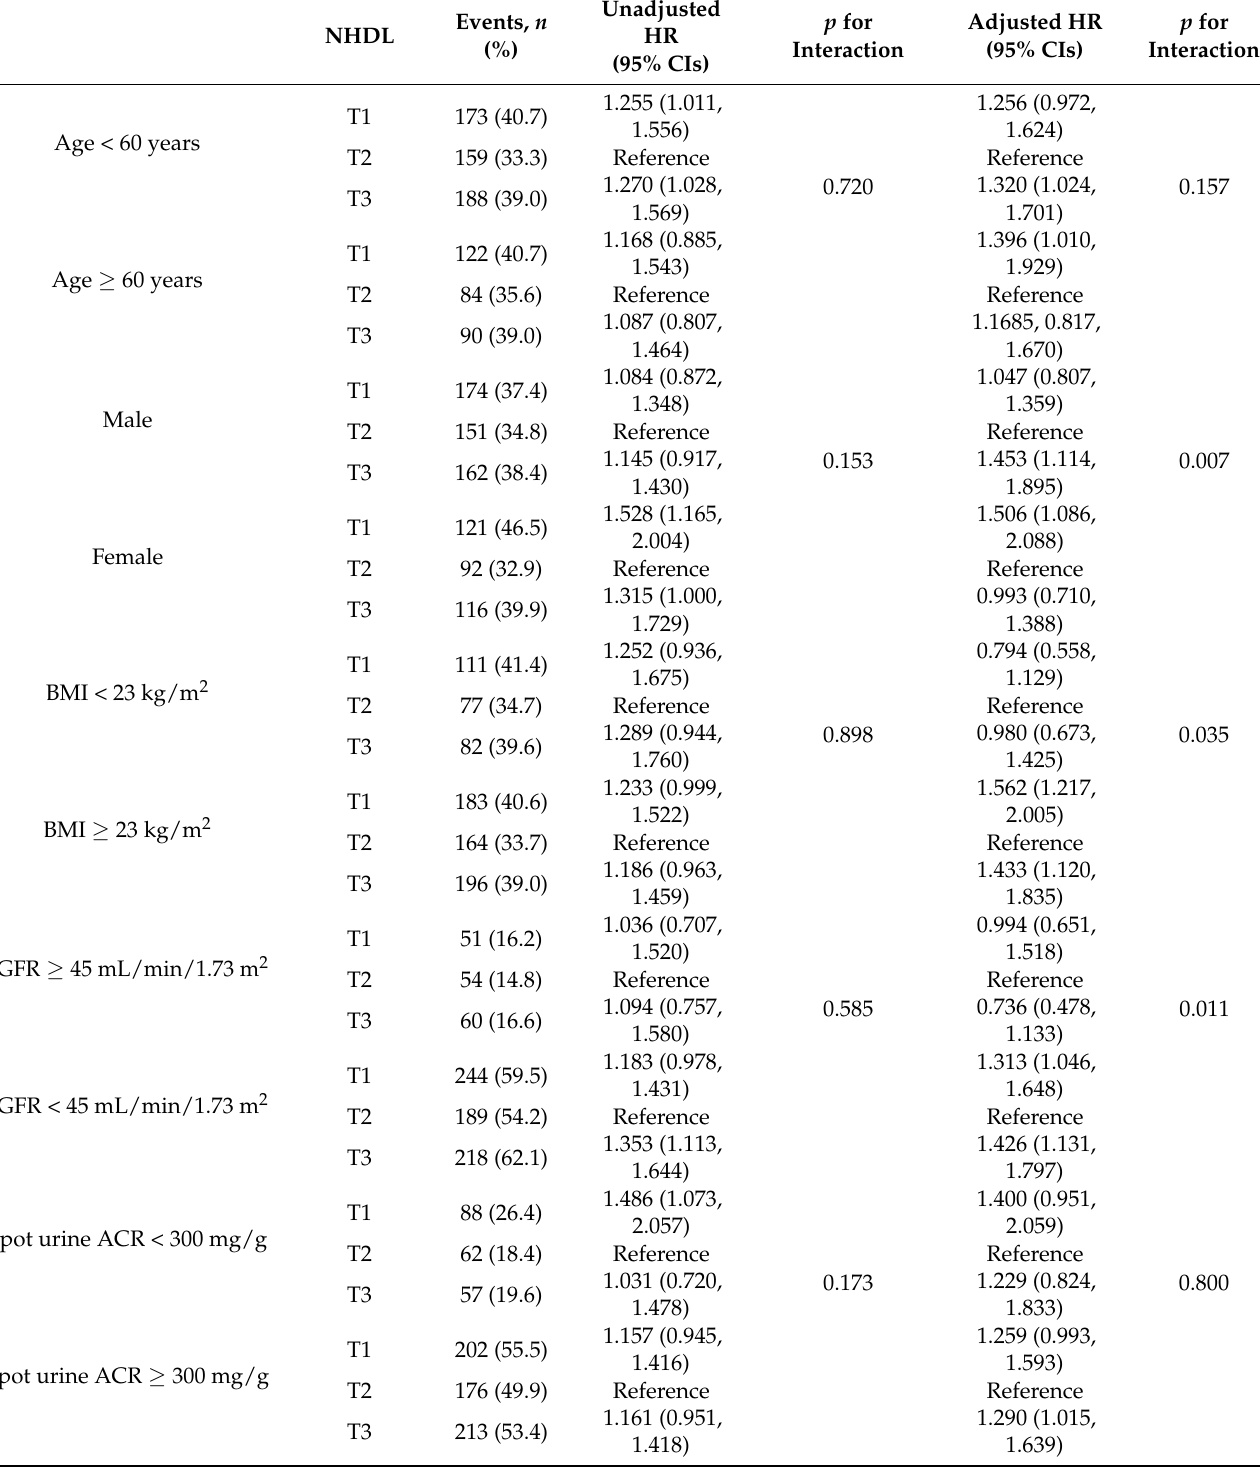
Table 5. HRs for the primary outcome by nHDL level in various